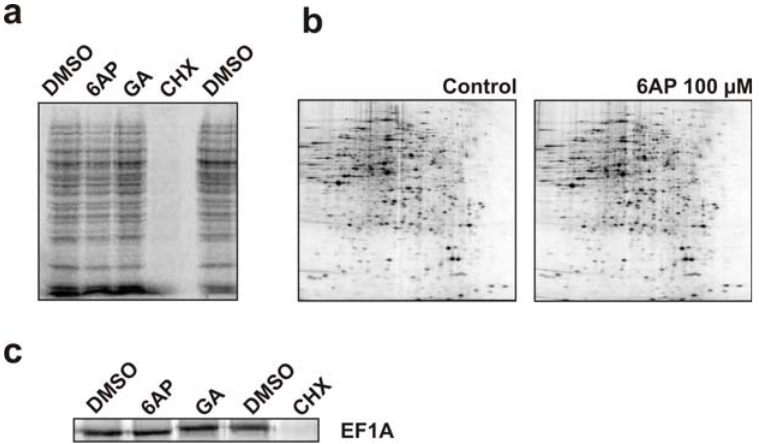
Figure 4. 6AP and GA do not affect the translational activity of the ribosome both invivo and invitro . a. The effect of the indicated compounds on general in vivo translation in living yeast cells was evaluated. Briefly, various drugs or DMSO (the compounds vehicle) alone were added to yeast cells in exponential growth in YPD rich medium at a final concentration of 100 m M. After 10 minutes, radiolabelled [ 35 S] methionine was added for 10 minutes. The cells were harvested to prepare cell extracts which were then analyzed by SDS-PAGE followed by autoradiography. Note that, with the exception of cycloheximide (CHX, a known inhibitor of general translation), none of the tested compounds has a significant effect on global protein synthesis. b. WT yeast cells were grown in the presence of DMSO (control left panel) or 100 m M 6AP (this concentration allows an efficient cure of prion) and cell extracts were then analyzed by 2D-SDS-PAGE followed by autoradiography. Note that no significant difference was observed between 6AP-treated cells and control cells. c. Effect of the indicated compounds on in vitro expression of EF1A using a commercial kit (Ambion). Note that only cycloheximide (CHX) significantly inhibits synthesis of EF1A.